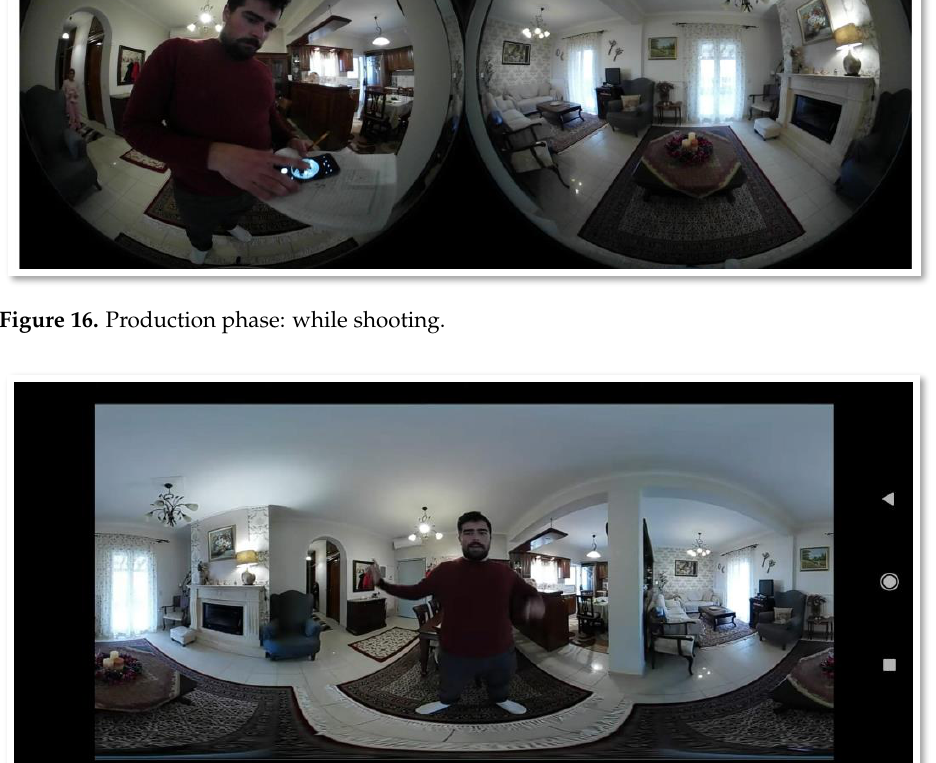
Figure 17. Production phase: while shooting.